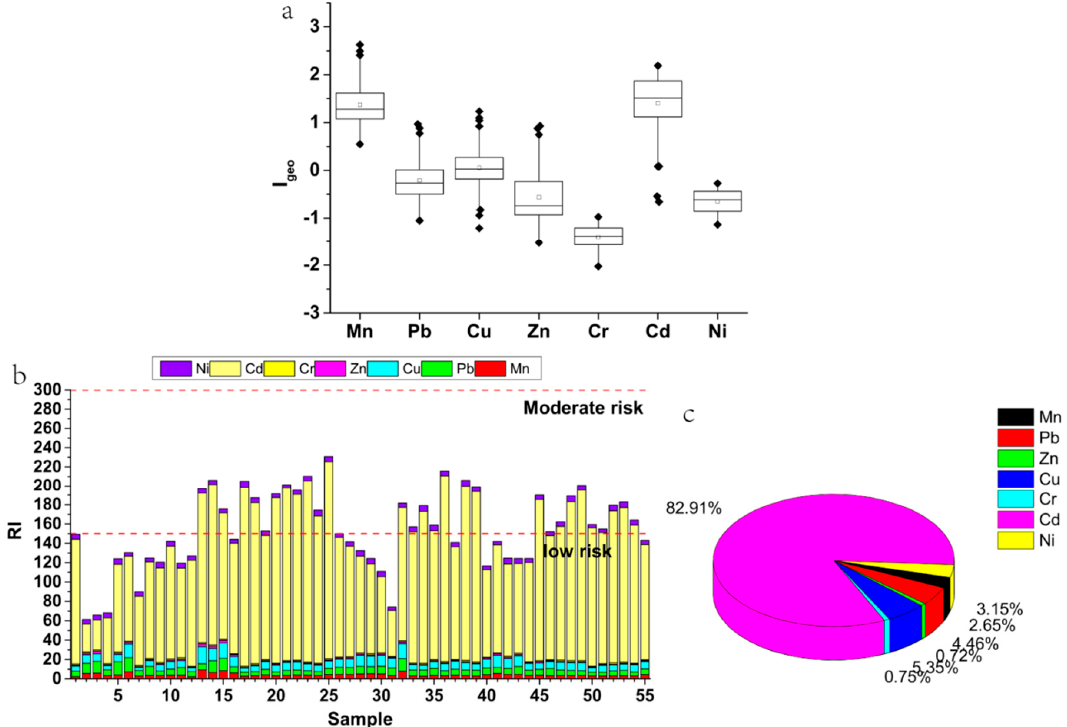
Figure 3. Contribution of the I geo ( a ), potential ecological risk index (RI) of PTEs ( b ) and the E i r of various elements to RI ( c ) in the soil of the study area.